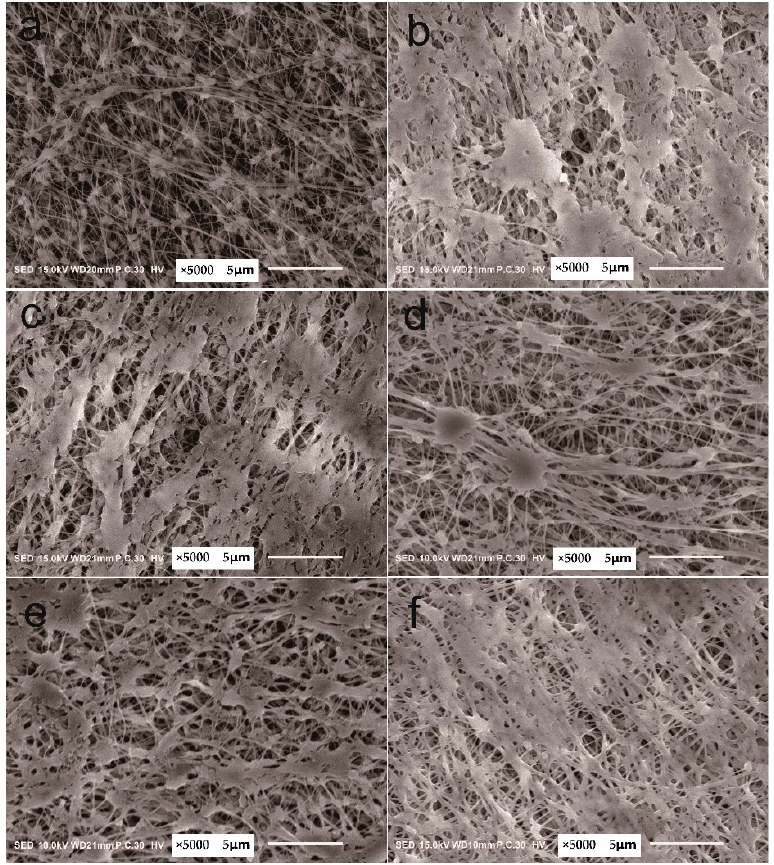
Figure 3. SEM images of the surfaces of different PTFE microfiltration membranes (( a ): M 0 ; ( b ): M ‐ PVA5 ; ( c ): M ‐ PVA5/CA2 ; ( d ): M ‐ PEGML2 ; ( e ): M ‐ PEGML4 ; ( f ): M ‐ PEGML2/PVA5/CA2 ). ( b ): M- PVA5 ; ( c ): M- PVA5/CA2 ; ( d ): M- PEGML2 ; ( e ): M- PEGML4 ; ( f ): M- PEGML2/PVA5/CA2